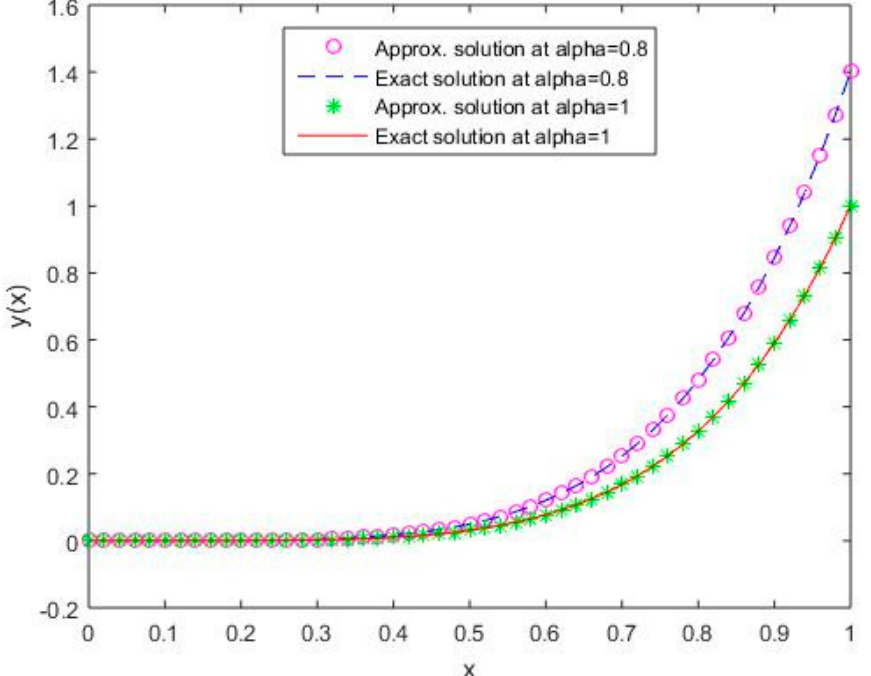
Figure 2. Comparison of exact and numerical solutions using S2 for α = 0.8 and α = 1, Example 1.